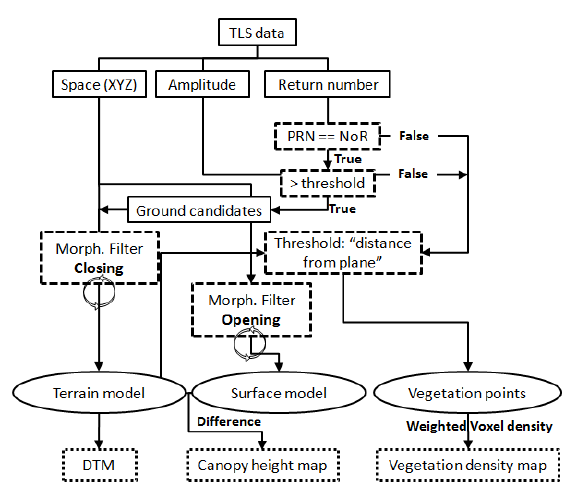
Figure 4. Workflow of processing pipeline: PRN is point return number, NoR is total number of returns.